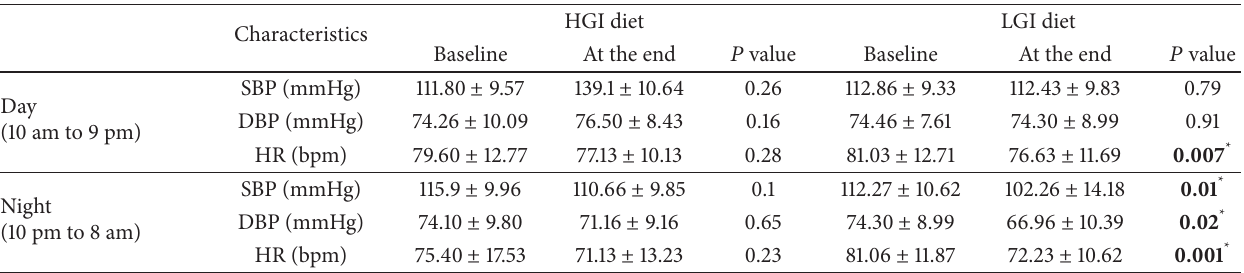
Table 5: The effects of LGI and HGI foods on SBP and DBP divided by day and night.